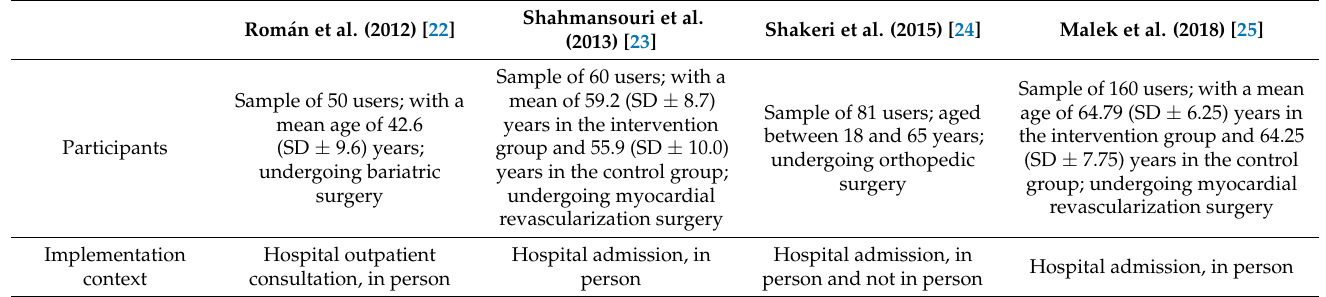
Table 1. Participants and contexts of implementation of intervention programs.